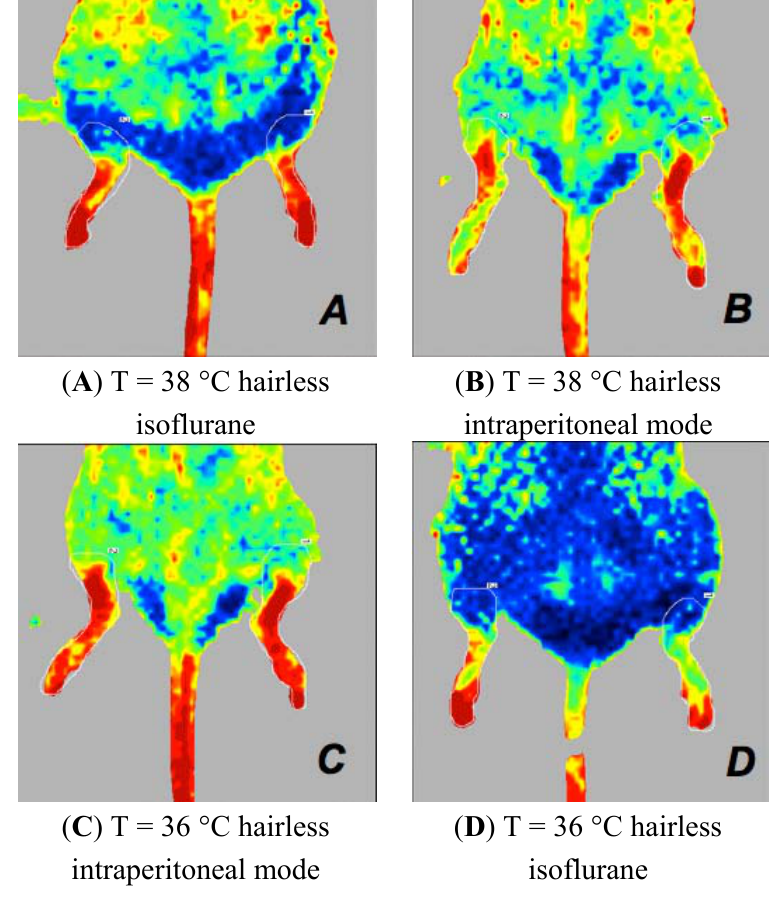
Figure 8. Laser Doppler images of the hind limbs of mice associated with the type of anaesthesia when the mouse is positioned in the ventral decubitus position. Mice anaesthetised with isoflurane have higher perfusion values when depilated with a depilatory cream and have a temperature of 38 °C ( A ) compared to mice that are under similar experimental conditions but are intraperitoneally anesthetised ( B ). Mice anaesthetised with intraperitoneal drugs and depilated with the cream have higher perfusion values at 36 °C ( C ) compared to mice that are under similar experimental conditions but are anaesthetised with isoflurane ( D